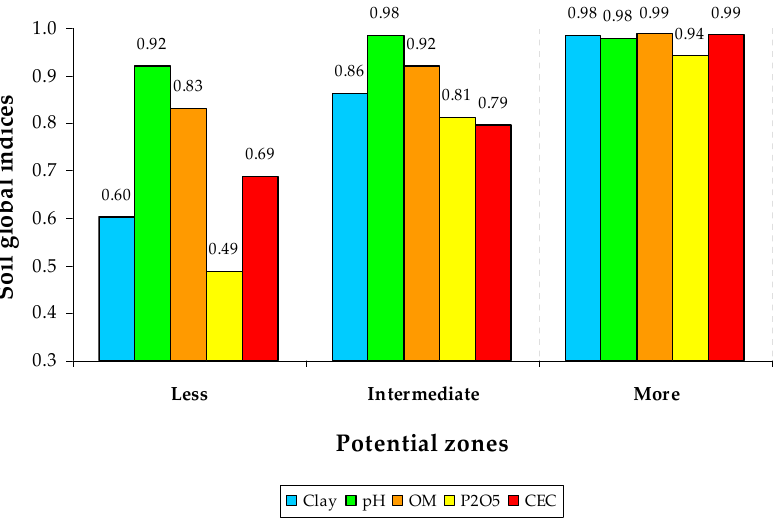
Figure 12. Global index of five soil parameters for each homogeneous management zone in the set of six experimental fields.